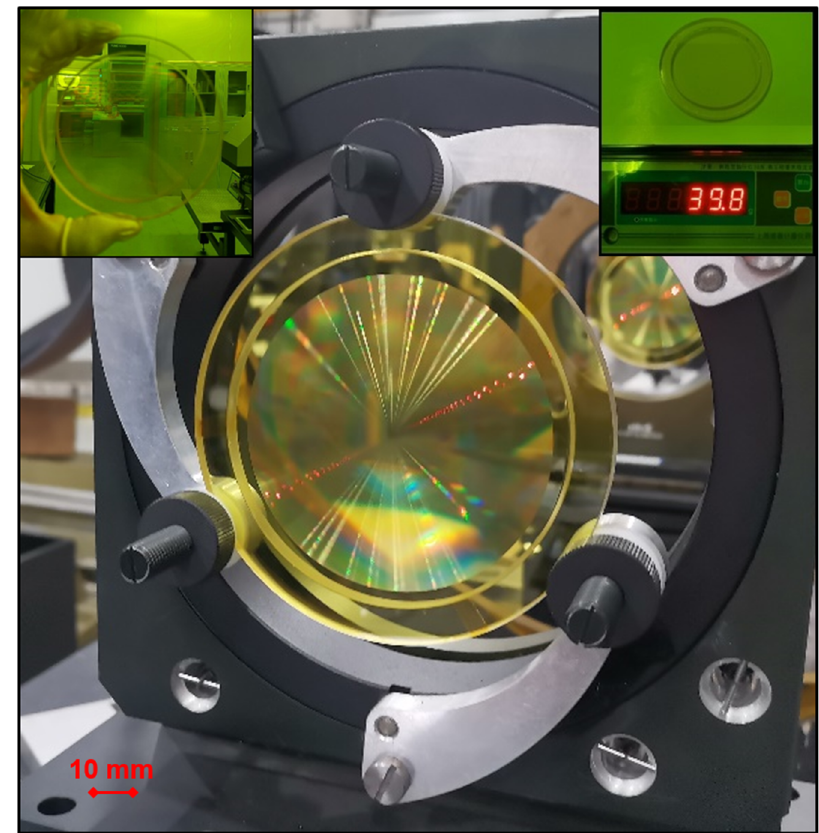
Figure 5. The membrane–Fresnel diffractive lens (M-FDL).